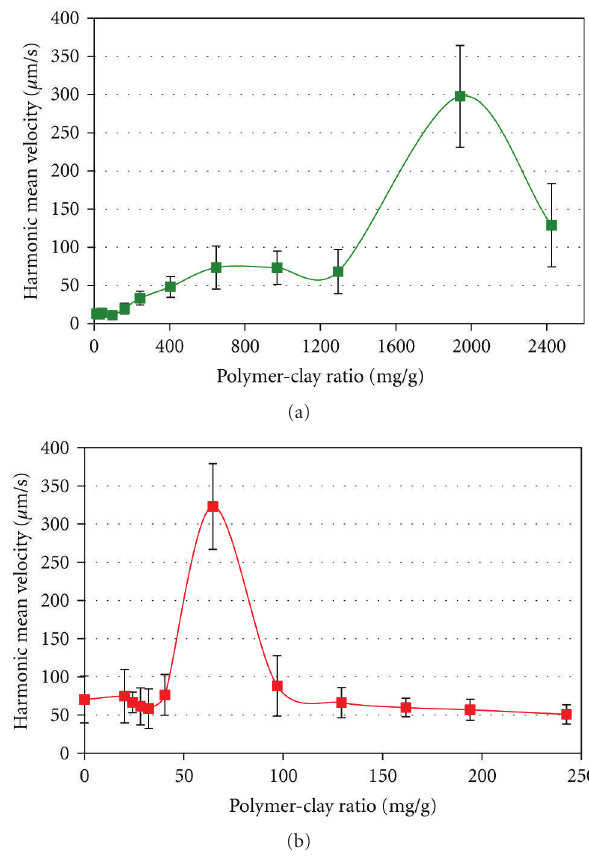
Figure 3: Harmonic mean sedimentation velocity of e ffl uents upon addition of 0.1% poly-DADMAC-sepiolite nanocomposite as a function of the polymer/clay ratio. (a) Olive oil wastewater; (b) winery wastewater.